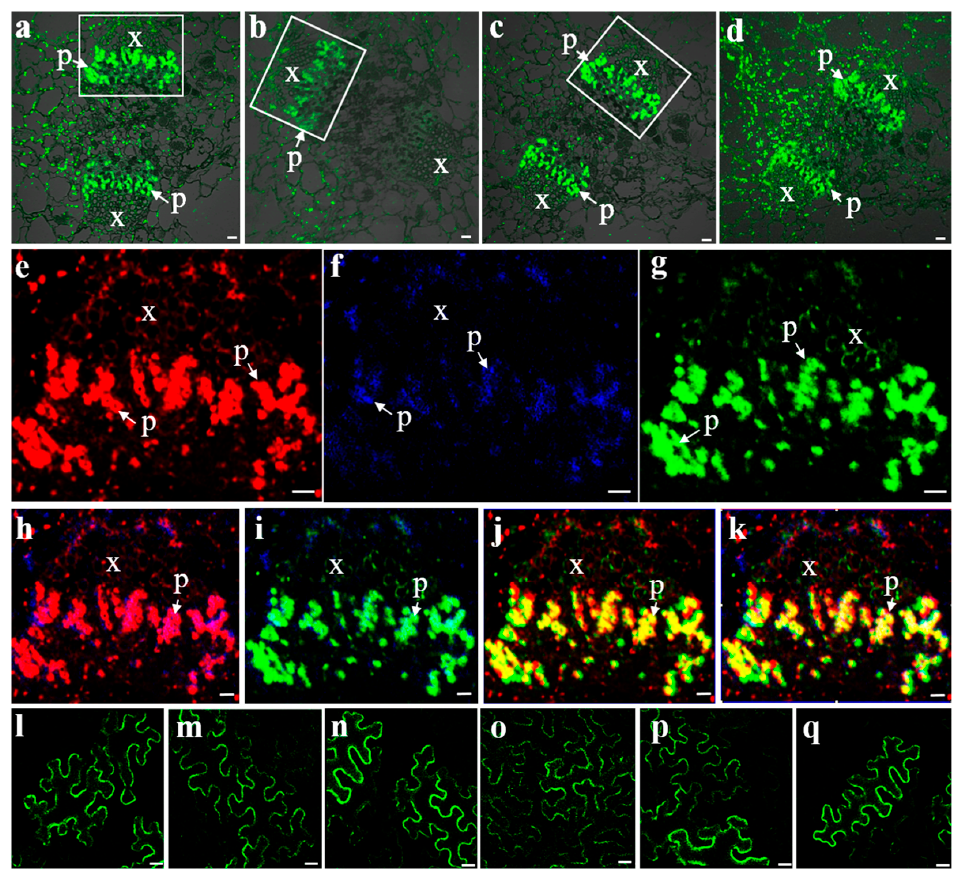
Figure 4. Fluorescent co-immunolocalization and BiFC interactions of VvSUCs. Fluorescent immunolocalization of VvSUC11 ( a ), VvSUC12 ( b ), VvSUC27 ( c ), and β -tubulin ( d ) in the central carpellary bundle of grapes. ( e – g ) Fluorescent co-immunolocalization of VvSUCs in the central carpellary bundle of grapes were marked by white boxes in ( a – c ). ( e ) Highlighted central carpellary bundle fluorescent immunolocalization of VvSUC11 in red. ( f ) Highlighted central carpellary bundle fluorescent immunolocalization of VvSUC12 in blue. ( g ) Highlighted central carpellary bundle fluorescent immunolocalization of VvSUC27 in green. ( h ) Fluorescent co-immunolocalization of VvSUC11 and VvSUC12. ( i ) Fluorescent co-immunolocalization of VvSUC12 and VvSUC27. ( j ) Fluorescent co-immunolocalization of VvSUC12 and VvSUC27. ( k ) Fluorescent co-immunolocalization of VvSUC11, VvSUC12, and VvSUC27. x: xylem; p: phloem. Scale bar, 10 µ m. ( l – q ): BiFC interactions between two homo- or hetero-SUTs. For homodimers, ( l ) YFP-VvSUC11 and VvSUC11-YFP, ( m ) YFP-VvSUC12 and VvSUC12-YFP, and ( n ) YFP-VvSUC27 and VvSUC27-YFP were co-expressed in tobacco. For hetero-oligomers, ( o ) YFP-VvSUC11 and VvSUC12-YFP, ( p ) YFP-VvSUC12 and VvSUC27-YFP, and ( q ) YFP-VvSUC27 and VvSUC11-YFP were co-expressed in tobacco. Scale bar, 10 µ